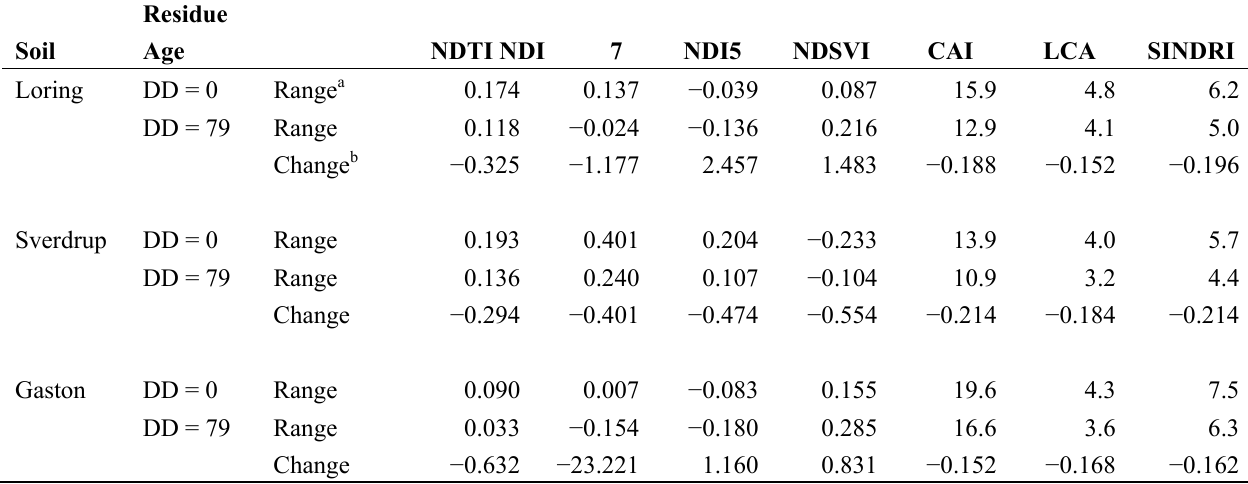
Table 1. Effects of soil type and residue age on the range of spectral residue